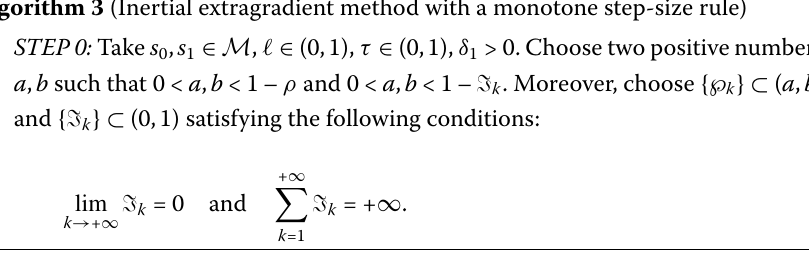
Algorithm 3 (Inertial extragradient method with a monotone step-size